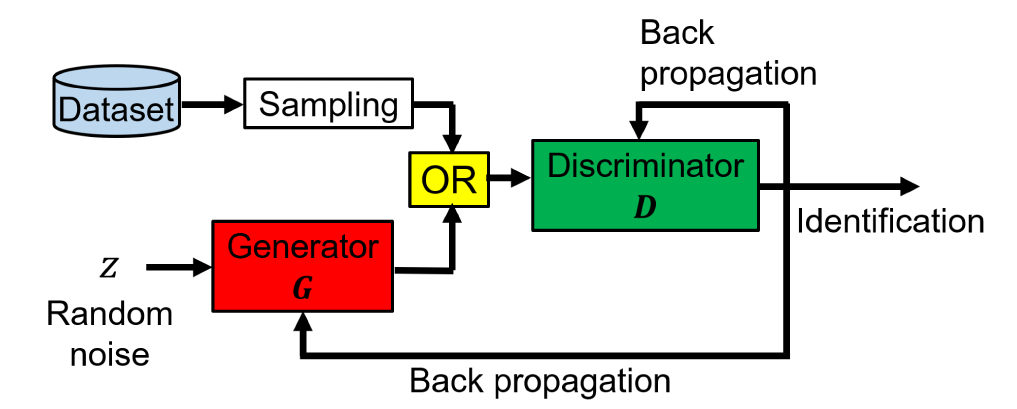
Figure 8. Structure of generative adversarial network (GAN)